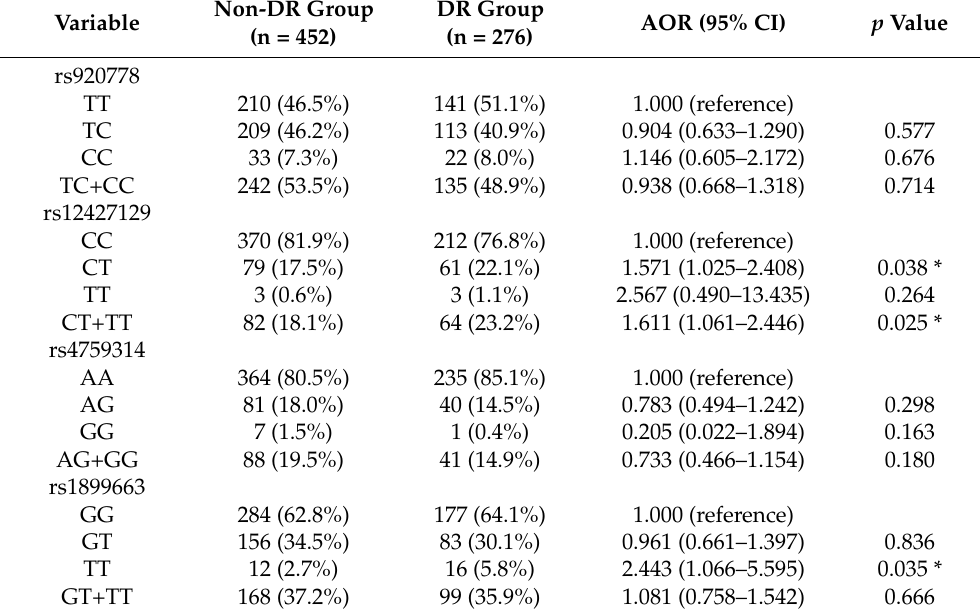
Table 2. Odds ratio and 95% confidence interval of diabetic retinopathy associated with HOTAIR genotypic